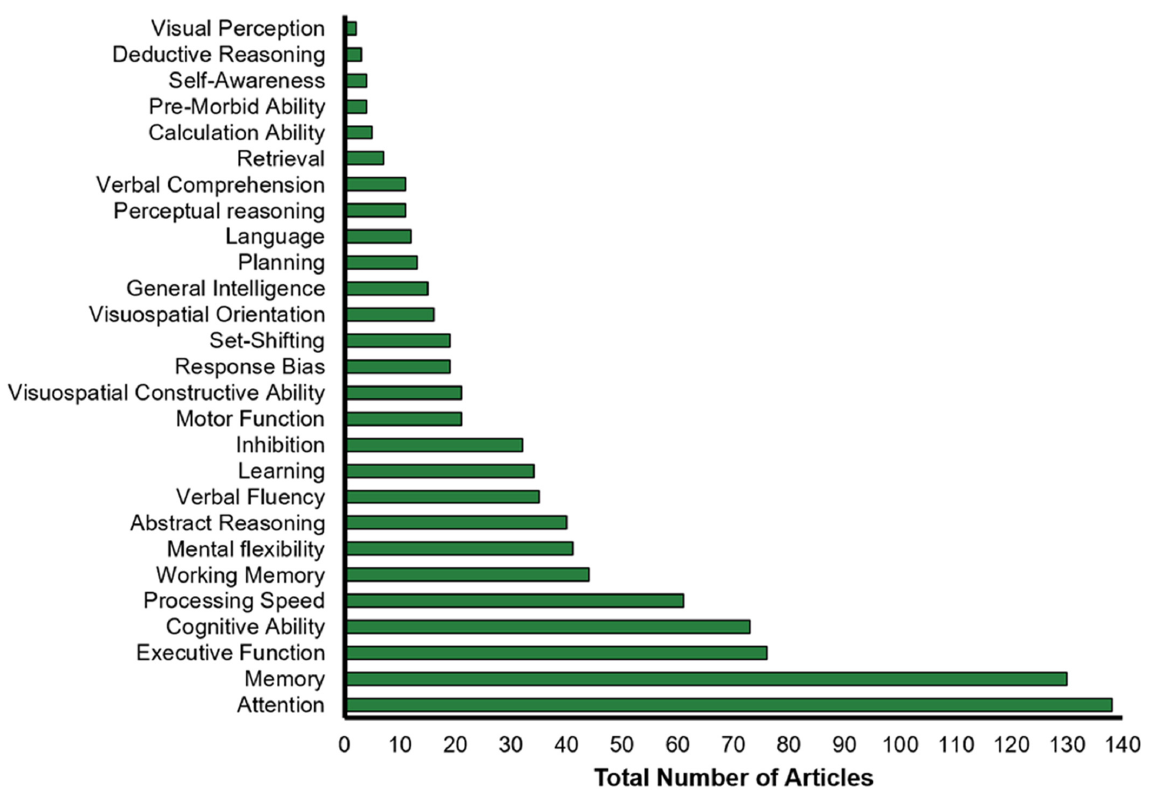
Figure 4. Number of articles that assess each cognitive domain. Only cognitive instruments that were listed in three or more articles are included in this analysis.